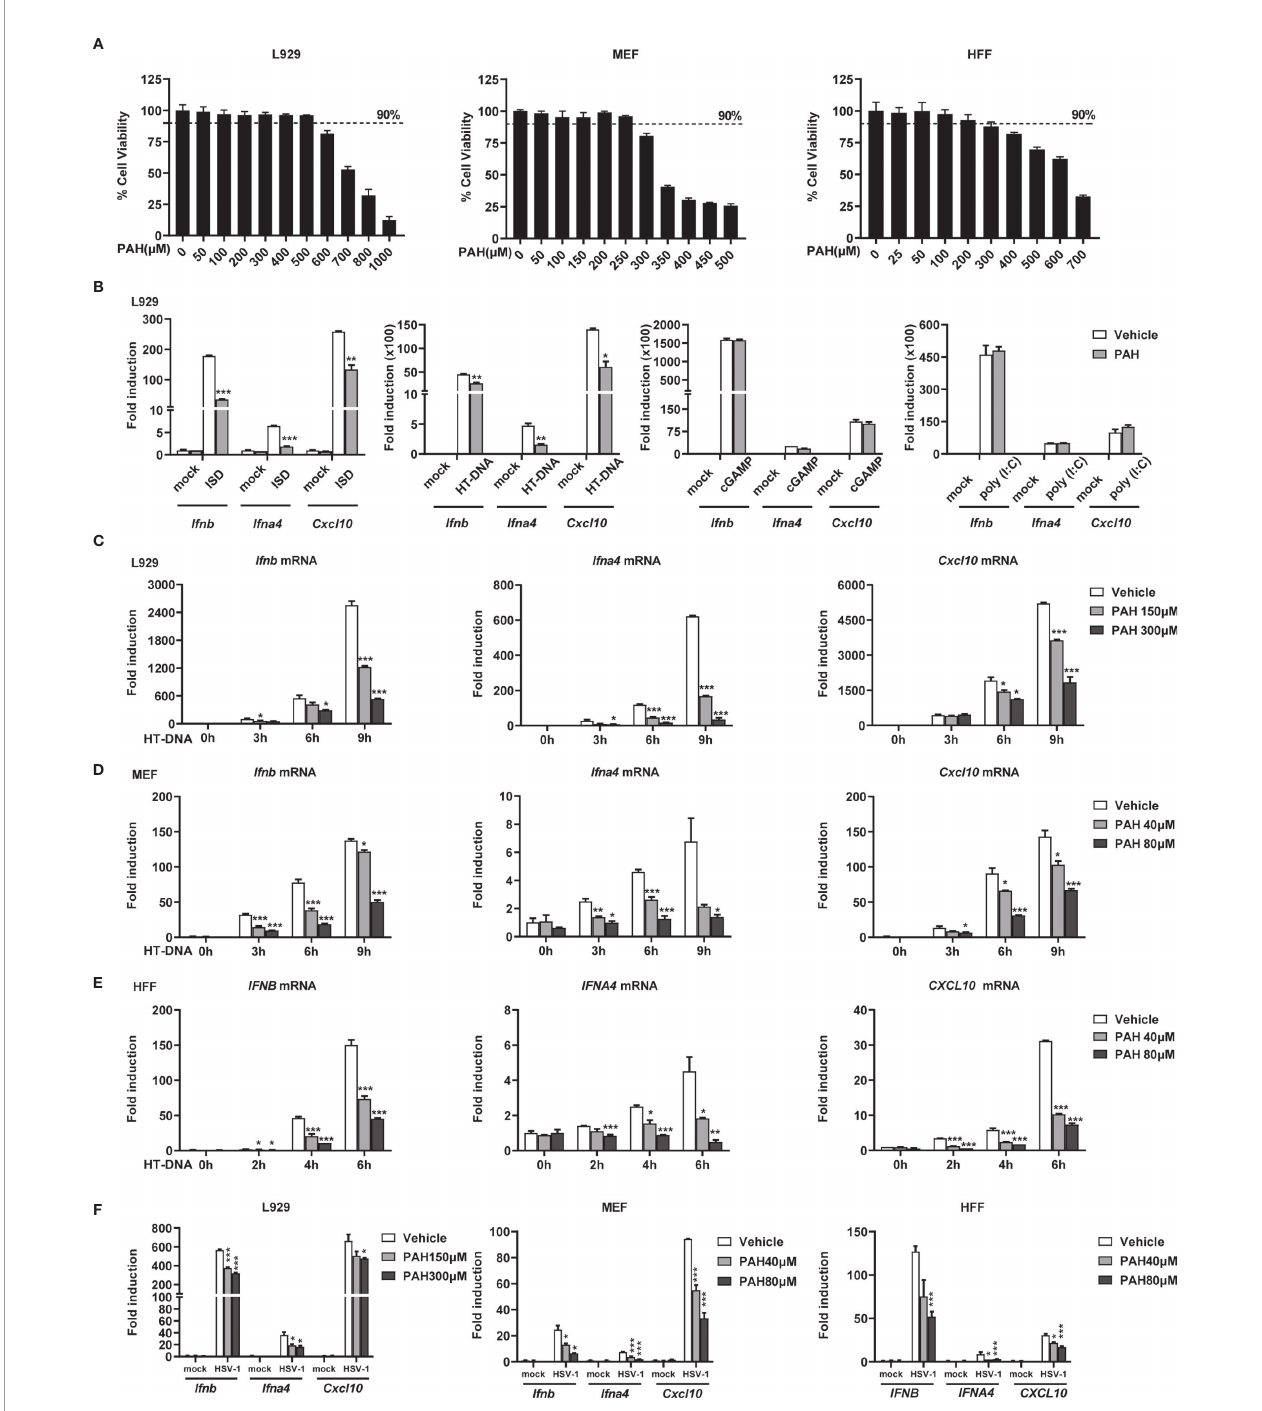
FIGURE 1 | PAH inhibits cytosolic DNA-triggered type I IFNs production. (A) L929, MEF, and HFF cells were treated with indicated PAH concentrations for 24 h, and then the cell proliferation was measured by MTS assay. (B) L929 cells were treated with Vehicle or PAH (300 m M) for 6 h and then stimulated with ISD (4 m g (cid:129) ml − 1 ), HT-DNA (4 m g (cid:129) ml − 1 ), cGAMP (1 m g (cid:129) ml − 1 ), or poly(I:C) (3 m g (cid:129) ml − 1 ). The induction of Ifnb , Ifna4 , and Cxcl10 mRNA expression was then measured by qPCR. (C – E) L929 (C) , MEF (D) , or HFF (E) cells were treated with Vehicle or PAH for 6 h and then stimulated with HT-DNA (4 m g (cid:129) ml − 1 ) for the indicated times. The induction of Ifnb , Ifna4 , and Cxcl10 mRNA expression was then measured by qPCR. (F) L929, MEF, or HFF cells were treated with Vehicle or PAH for 6 h and then infected with HSV-1 (MOI = 1) for 6 h (L929 and MEF) or 3 h (HFF). The induction of Ifnb , Ifna4 , and Cxcl10 mRNA expression was then measured by qPCR. All of the experiments were repeated at least three times. Data in (A – F) are presented as mean ± SD. * P < 0.05, ** P < 0.01, *** P <